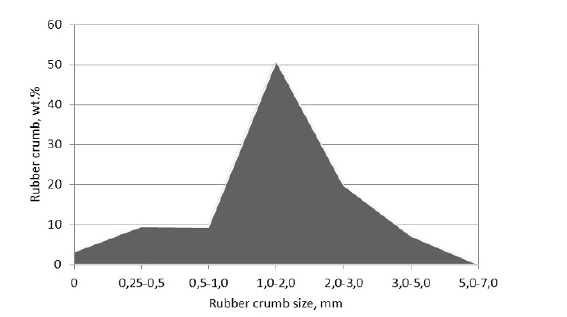
Figure 1. The particle size distribution of non-fractionated rubber crumb